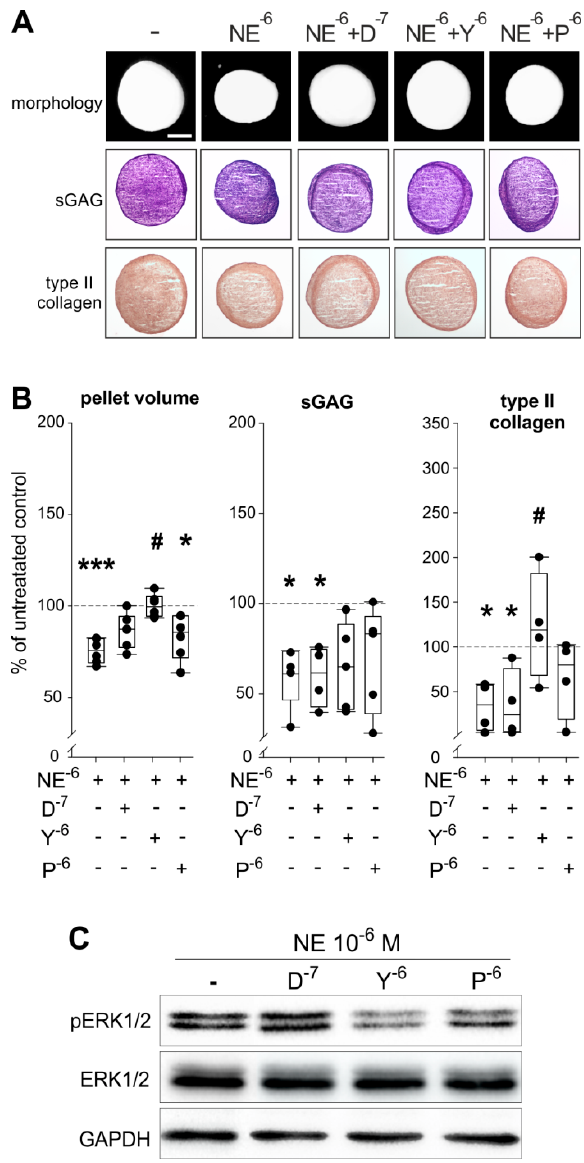
Figure 6. Effect of specific AR antagonists on NE effects during sASC chondrogenesis. ( A ) Macroscopic, histologic (sGAG) analysis and immunohistochemical type II collagen staining of chondrogenic sASC pellets treated with NE (10 − 6 M) or with NE plus specific AR antagonists at day 21 of differentiation (bars 500 μ m). ( B ) Quantification of pellet volume and biochemical quantification of type II collagen and sGAG content of chondrogenic sASC pellets treated with NE (10 − 6 M) or with NE plus specific AR antagonists at day 21. Each circle shows the mean of 3 replicates per patient ( n = 6–10). Values are the percent of control (control = 100%, dashed line). Significant p -values against untreated control are presented as * p < 0.05, *** p < 0.001; # p < 0.05 to NE-treatment. ( C ) Western blot analysis of total ERK1 / 2 and ERK1 / 2 phosphorylation in of chondrogenic sASC pellets treated with NE (10 − 6 M) or with NE plus specific AR antagonists: representative blot of one